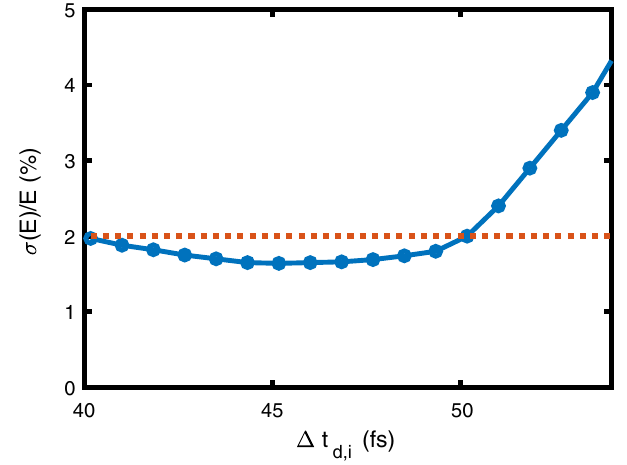
FIG. 11. Longitudinal jitter analysis. AL a D yn 2D slab simula- tions with varying transverse offset from the ionizing pulse (on axis) and the driving train. The x represents the distance of offset the train center-of-mass from the simulation axis. The center-of- mass transverse momentum (orange) and the normalized emit- tance (blue) dependence on x are offset